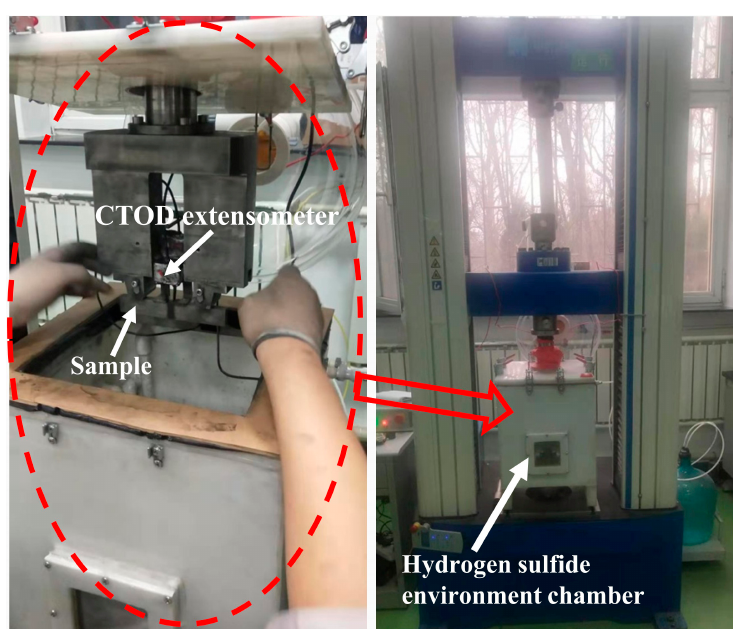
Figure 3. The equipment of hydrogen sulfide environment CTOD test.